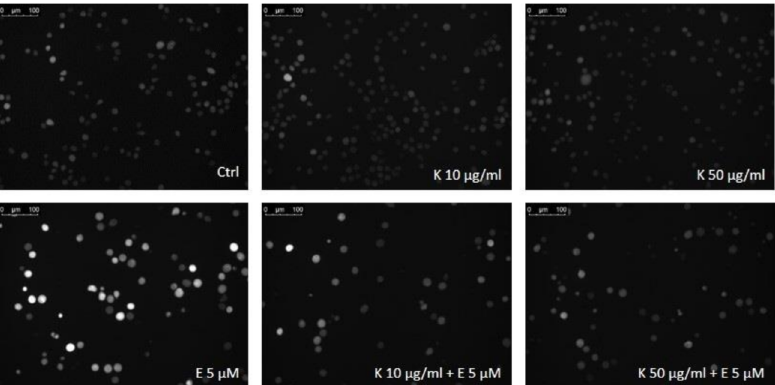
Figure 8. Representative photos of cells with 20 the fluorescence probe H 2 DCFH-DA after 24 h incubation at 37 ◦ C with 5 µ M etoposide (E) and 10 µ g/mL or 50 µ g/mL kaempferol (K). The figure also contains pictures of comets from negative control